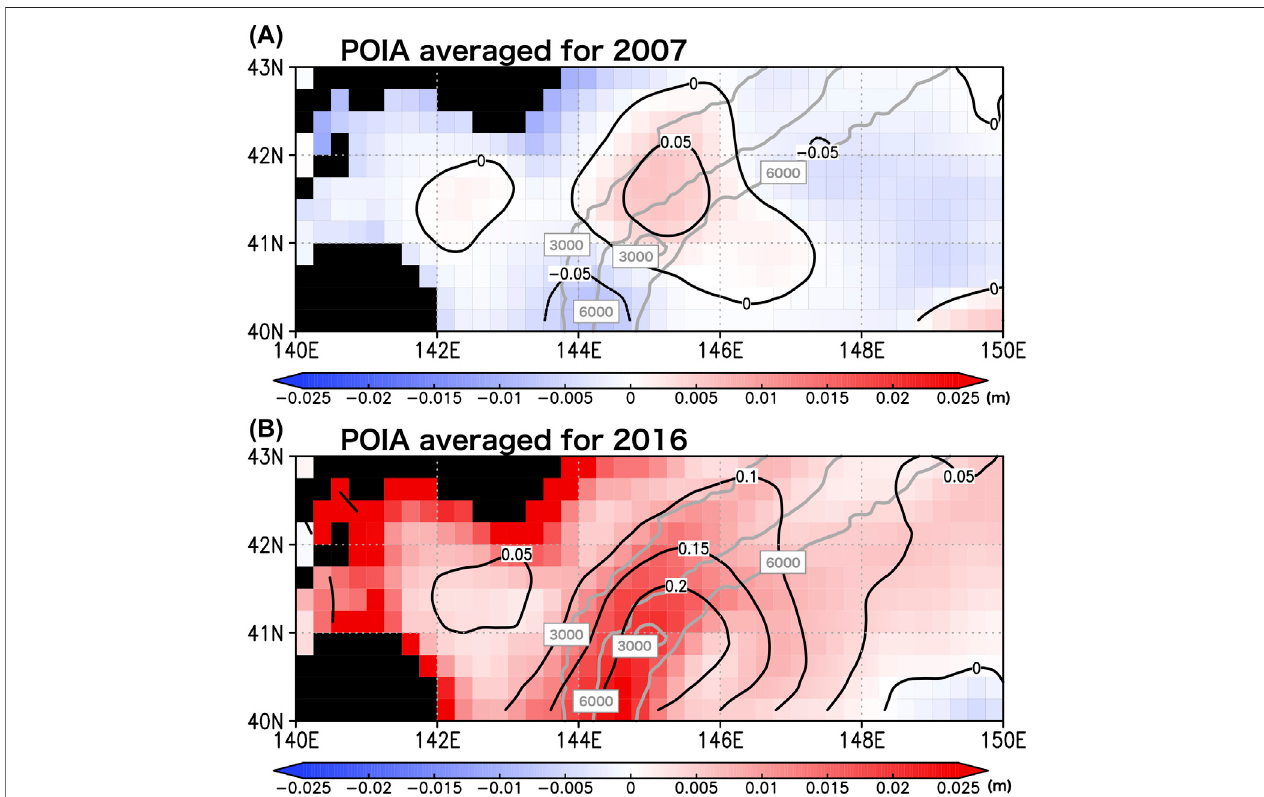
FIGURE10|(A) SpatialdistributionoftheyearlyaveragedPOIAthatwerecalculatedbyuseoftheregressioncoef fi cientbetweentheSSHandSEPanomaliesfrom the JCOPE2M( Figure 7A ),and theobservedaltimetric SSH anomalies (AVISOSSH anomalies) ateach grid point onaninterannualtimescalefor theyear2007(shaded color).The yearly averaged the AVISO SSH anomalies for the year 2007 are shown by black contours. The unit ism. Thebottom depths of3000 and 6000m are shown by thegray solidcontours.Tomake the POIA,theregression coef fi cient betweenSSH and SEP anomalies fromthe JCOPE2M withthe 1/12 ° × 1/12 ° grid were re- griddedto matchthespatial grid pointofthe AVISO SSH anomalies withthe 1/4 ° × 1/4 ° grid byuse ofaspatial averaging oftheregressioncoef fi cient usinga0.1 ° spatial window centered at each grid point of the AVISO SSH anomalies. (B) Same as (A) but for the year 2016.